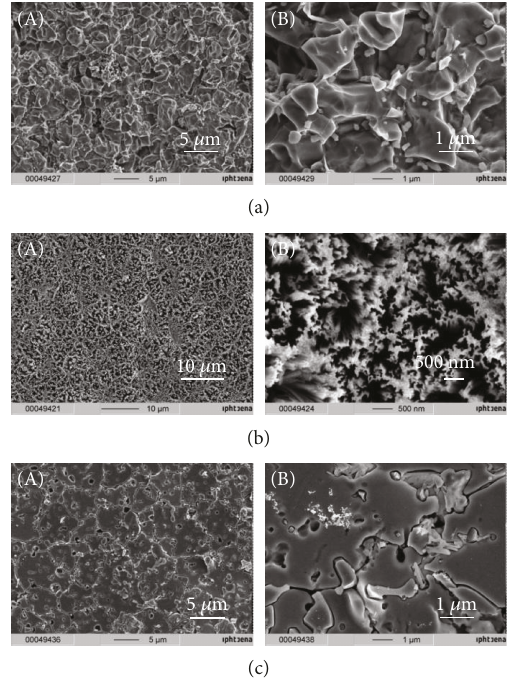
Figure 5: (a), (A) SEM image showing the surface textures of the nonirradiated pc-Si sample (only heat up to 600 ° C for about 2h without laser treatment) subject to a MAWCE process and (a), (B) the corresponding higher resolution SEM image; (b), (A) nanowires formed by MAWCE in the region treated with medium laser power density of 12.0 kWcm − 2 and (b), (B) the corresponding higher resolution SEM image; (c), (A) no nanowires being detected in the region treated with a laser power density of 13.5kW cm − 2 and (c), (B) the corresponding higher resolution SEM